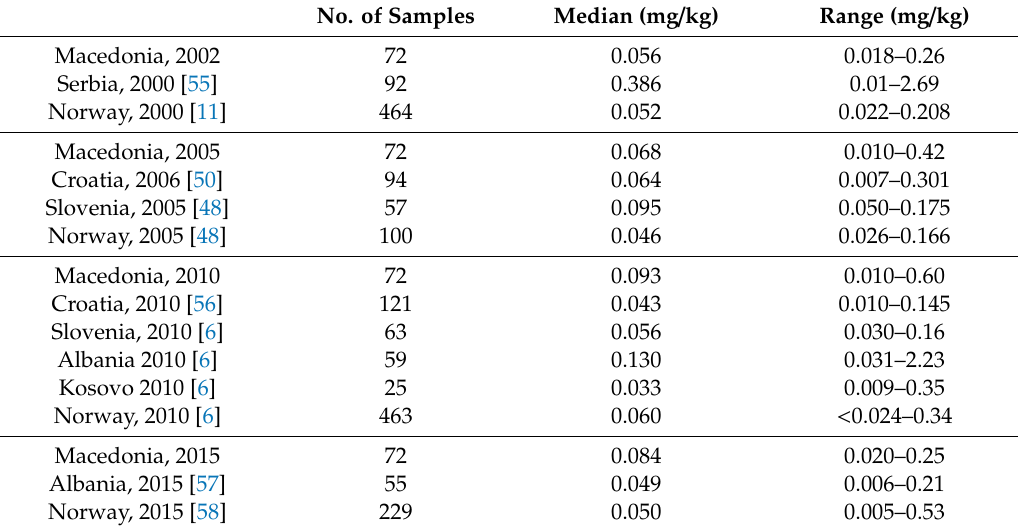
Table 2. The median values and ranges for the content of Hg obtained for Macedonia, neighbouring countries, and